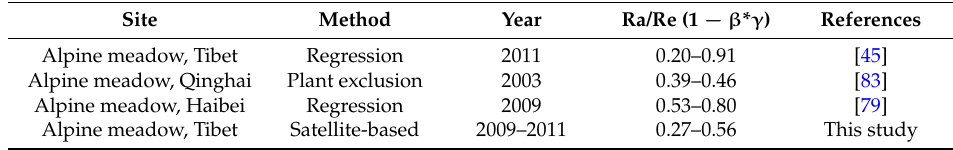
Table 4. Multi-site comparison of autotrophic contribution to ecosystem respiration (Ra/Re) in the alpine meadows on the Qinghai-Tibet Plateau.